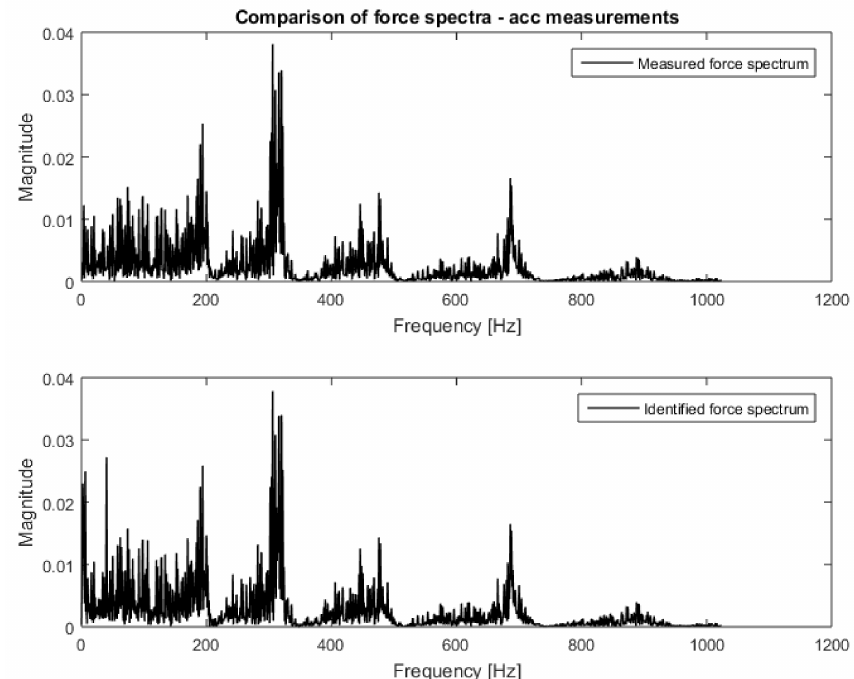
Figure 8. Comparison of measured and identified force spectra for the vibrations’ acceleration measurements (entire frequency range).